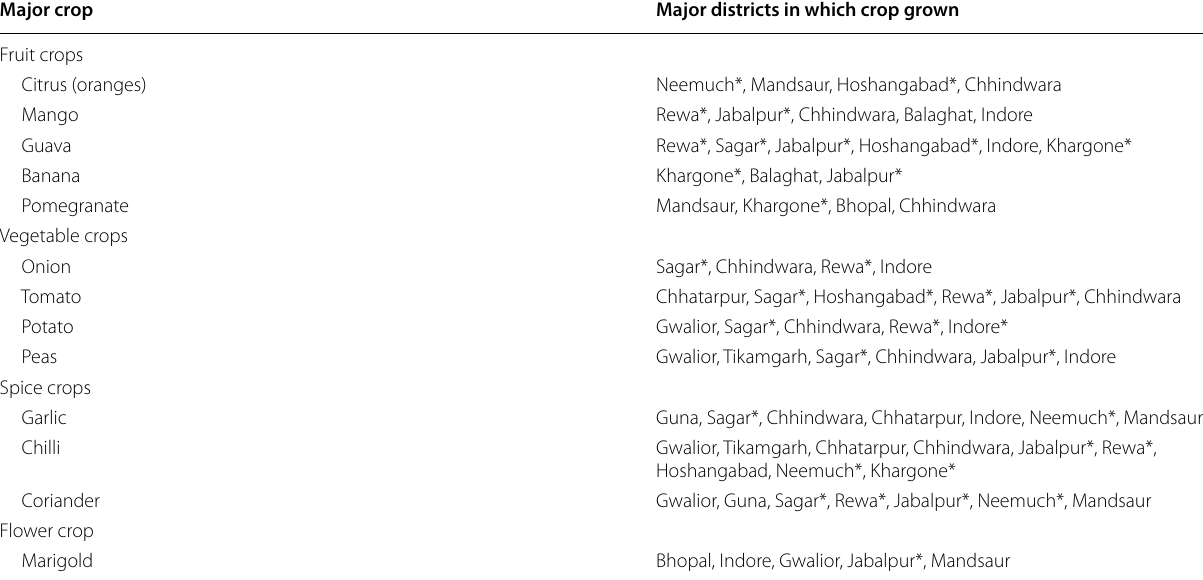
The districts with the asterisk mark are the predicted vulnerable districts for climate change. The horticultural crops grown in these districts may be adversely affected